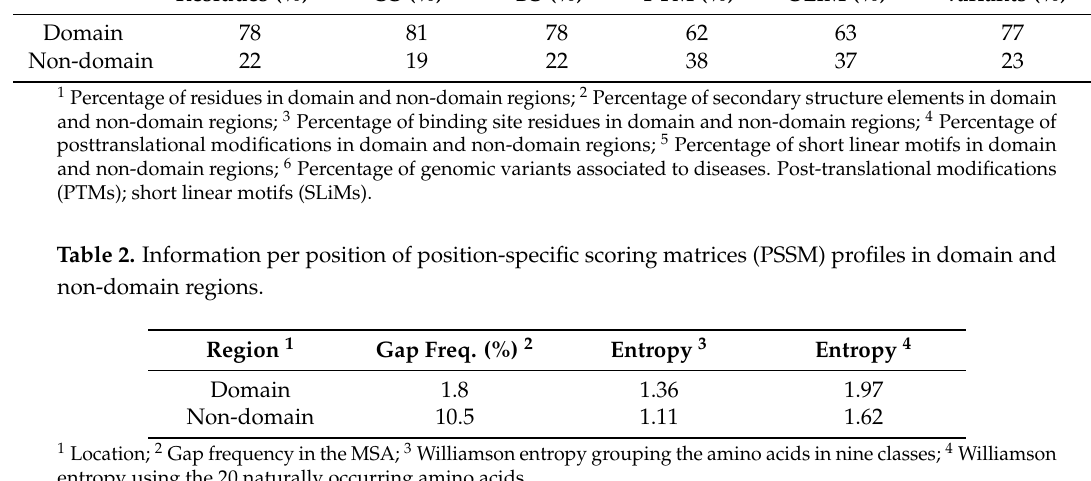
Table 1. Biological features of domain and non-domain residues for Protein Data Bank (PDB) proteins. Residues (%) 1